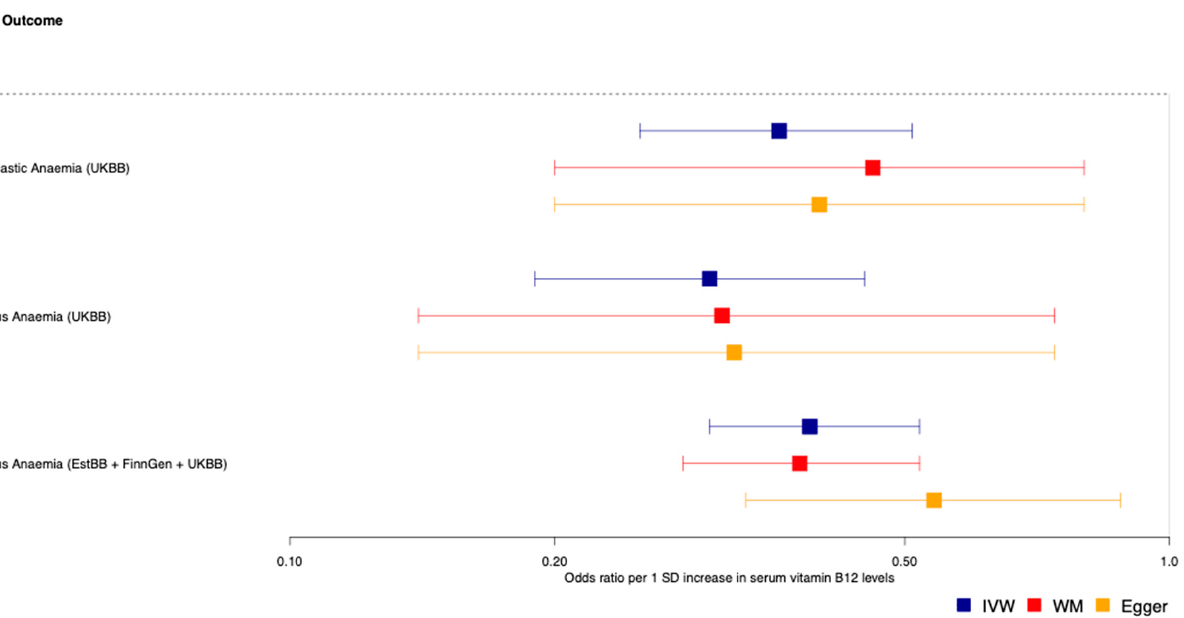
Figure 2. Forest plots for the Mendelian randomisation effect of genetically predicted vitamin B 12 levels on megaloblastic and pernicious anaemia. Blue, red and yellow squares and lines depict odds ratios and 95% confidence intervals for inverse-variance weighted (IVW), weighted median (WM) and Egger MR analyses, respectively. Table 2. Mendelian randomisation analyses of vitamin B 12 status and associated health outcomes. MR-Weighted Outcome MR-IVW MR-Egger Median